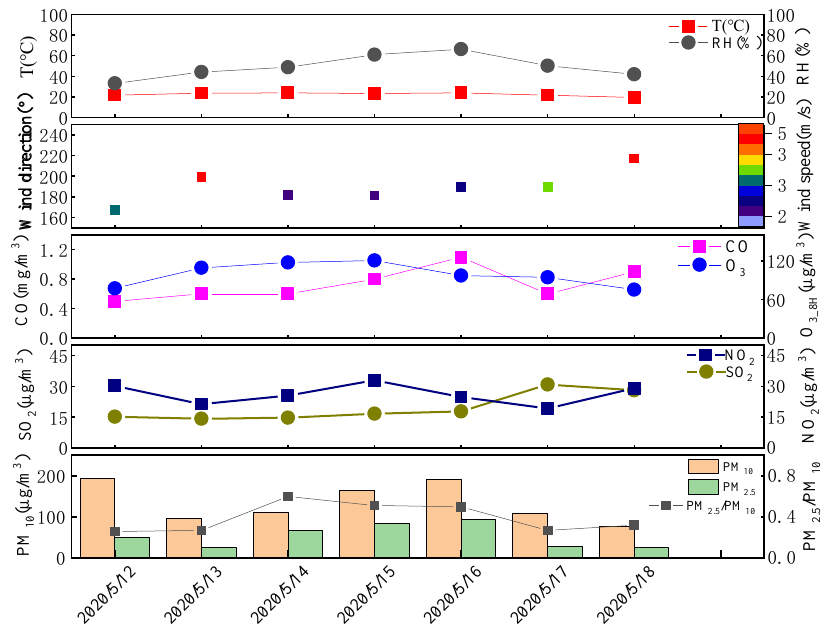
Figure 2. Time series of PM concentration, gaseous pollutants and meteorological conditions.